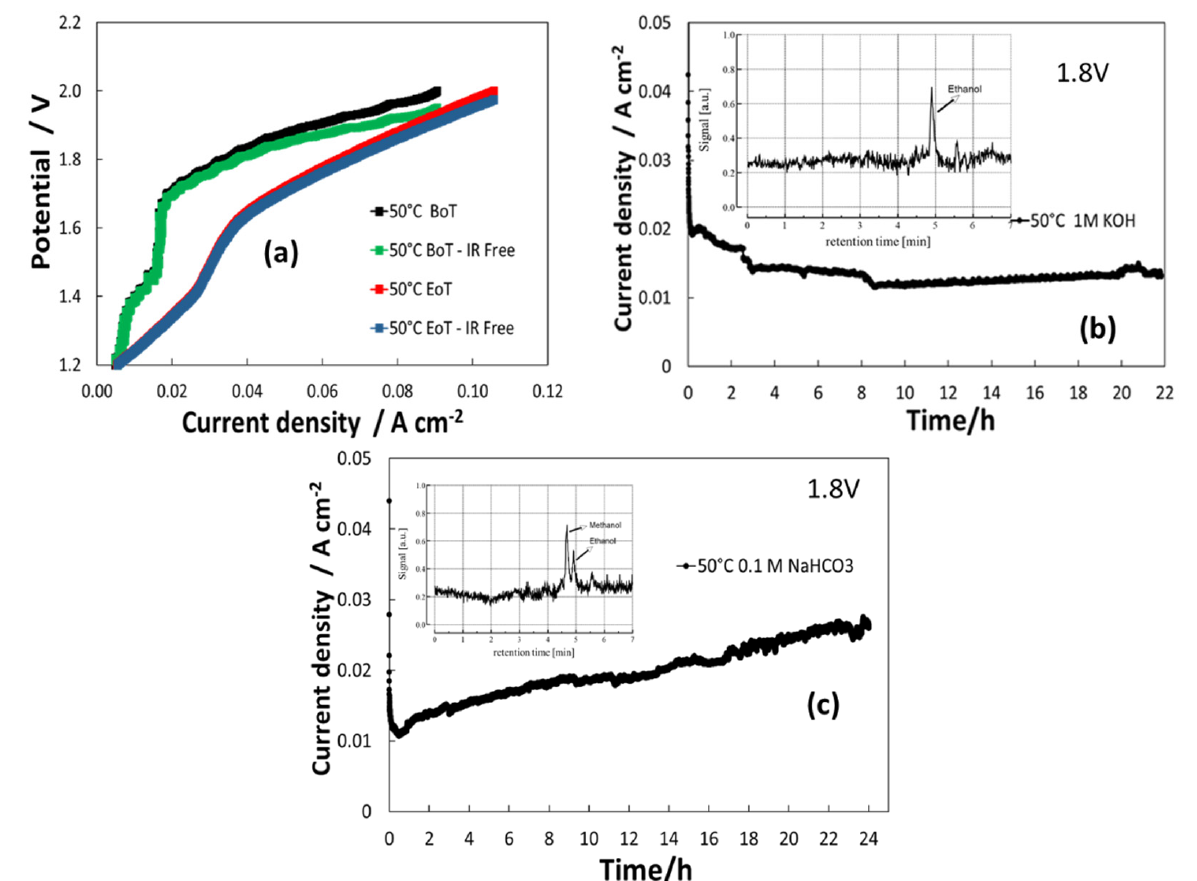
Figure 9. Polarization curves at 50 °C ( a ) CuOxAg/KB-Sustainion X37-50-NiFeO x KB (BoT Rs = 0.54 Ohm cm 2 and EoT Rs = 0.24 Ohm cm − 2 ). ( b ) Liquid-phase analysis at the cathode outlet, in the presence of 1M KOH at 1.8 V. ( c ) Liquid-phase analysis at the cathode outlet, in the presence of 0.1 M NaHCO 3 at 1.8 V.